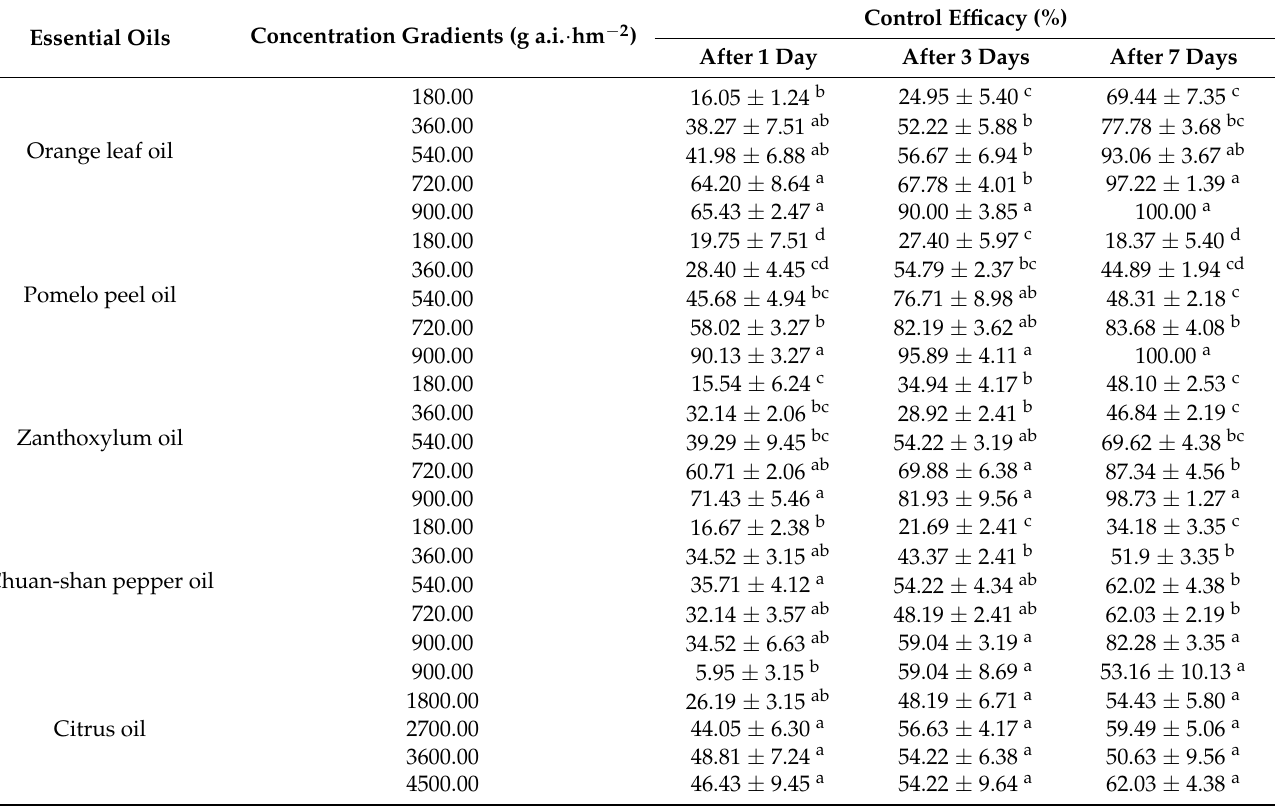
Table 3. Control efficacy of essential oils in Thrips flavus